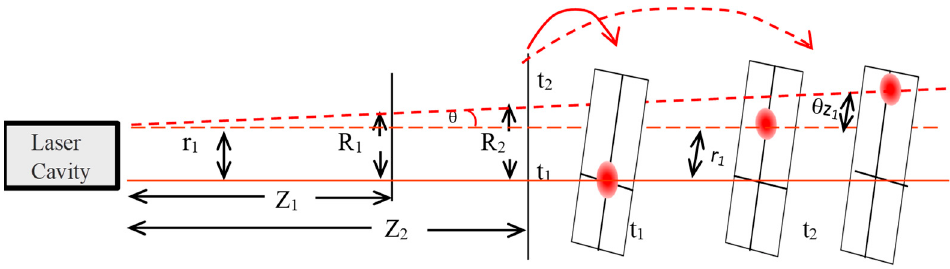
Figure 2. Transversal shifts of laser propagation, the illustration shows two observers placed at 𝑧 (cid:2869) and 𝑧 (cid:2870) , at 𝑡 (cid:2869) (solid line) and 𝑡 (cid:2870) (dashed lines), respectively. We assumed a centered beam at time